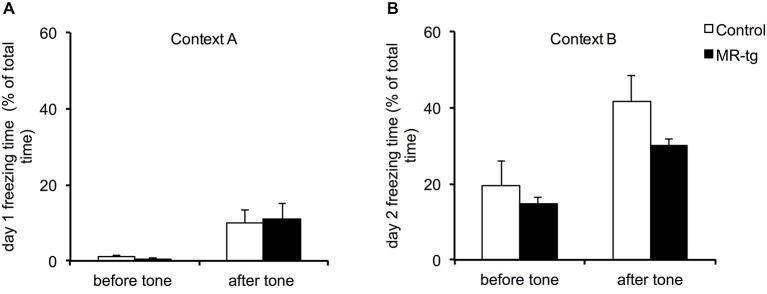
Effects of MR overexpression on cue fear conditioning. (A) During training, comparison between MR-tg and control mice revealed no differences in freezing behavior before as well as after the presence of the tone. n = 8 per group. (B) Twenty-four hours later, both MR-tg and control mice showed similar freezing behavior in response to the new context, when compared before and after the tone presentation. n = 8 per group.